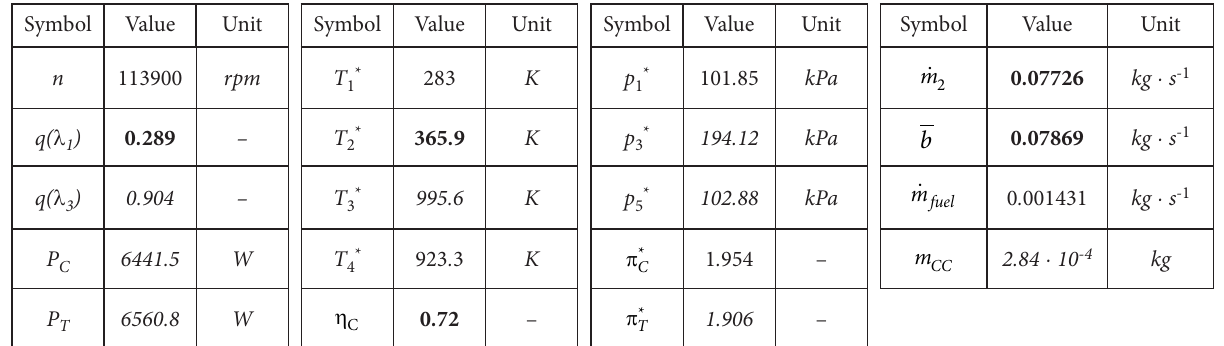
Table 2. Measured and computed values of gas turbine process parameters